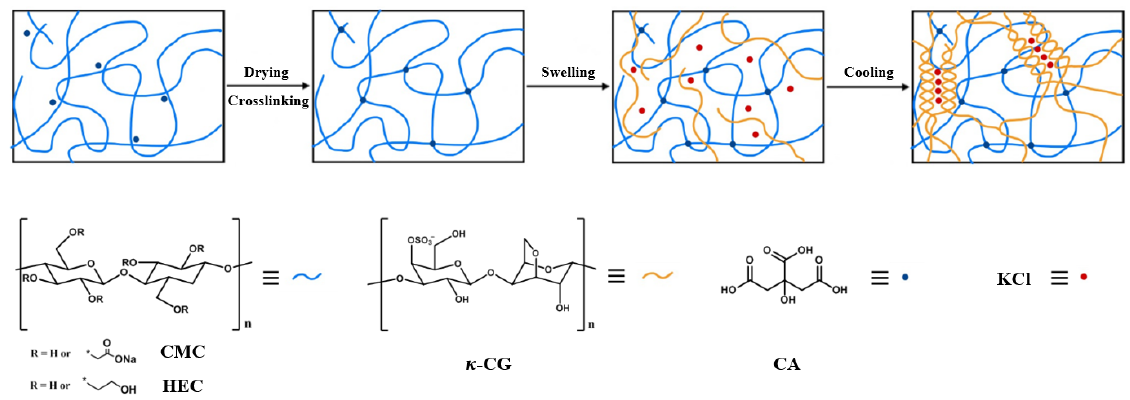
Figure 1. Schematic illustration of the synthesis of the DN hydrogel.